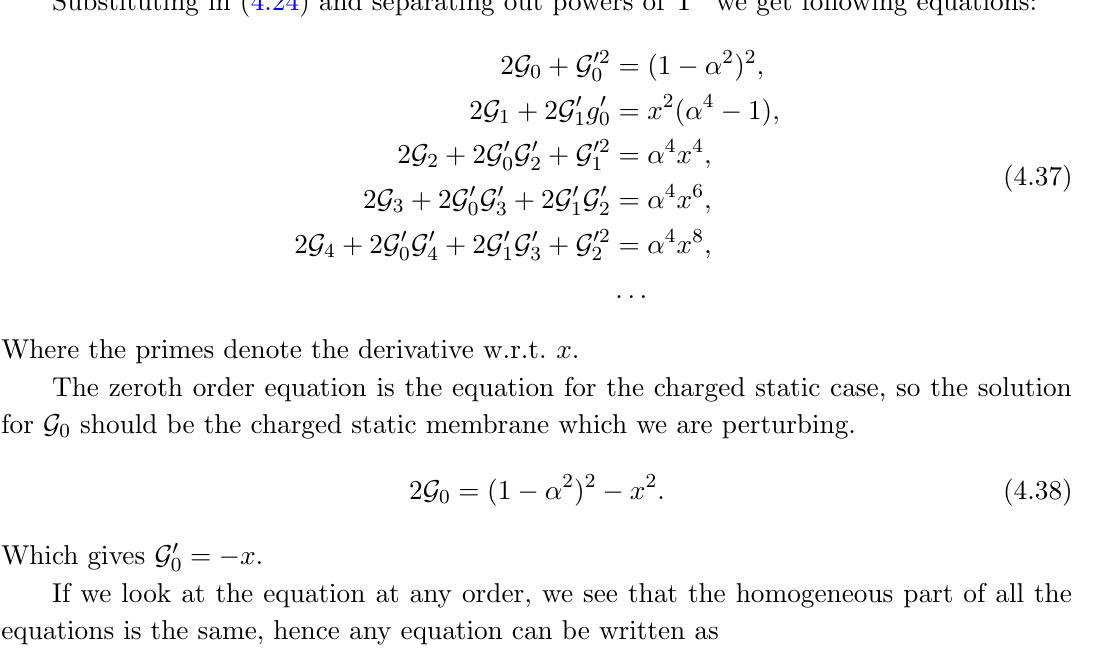
Figure 2 . The inner red surface corresponds to the solution for the charged membrane with (cid:11) = 0 : 2 and (cid:7) = 0 : 47 for the + branch while the outer blue surface is for the uncharged membrane.